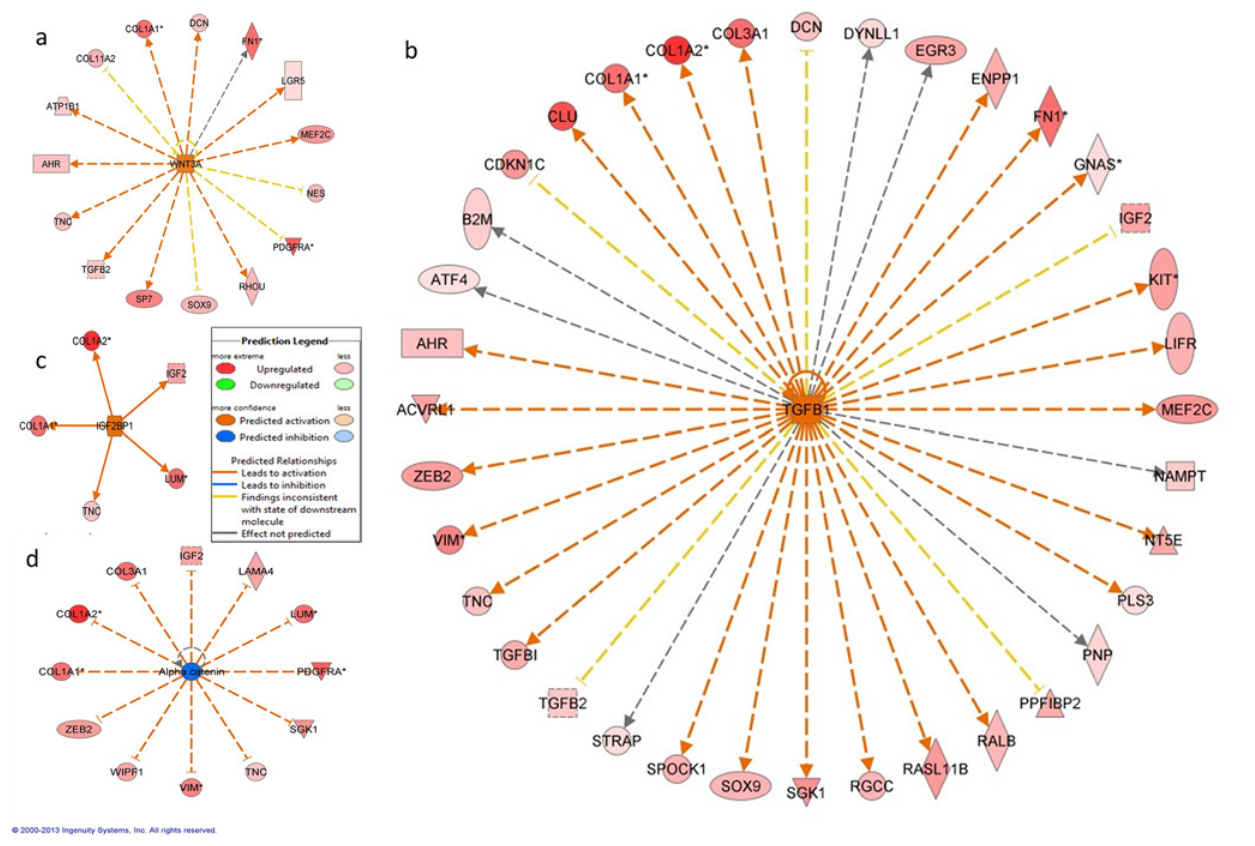
Fig 4. Upstream analysis: a — molecule network map for WNT3A, b — molecule network map for TGFB1, c — molecule network map for IGF2BP1, d — molecule network map for Alpha catenin. The predicted molecule is in the center with linkage to downstream targets based on differential expression from SAM